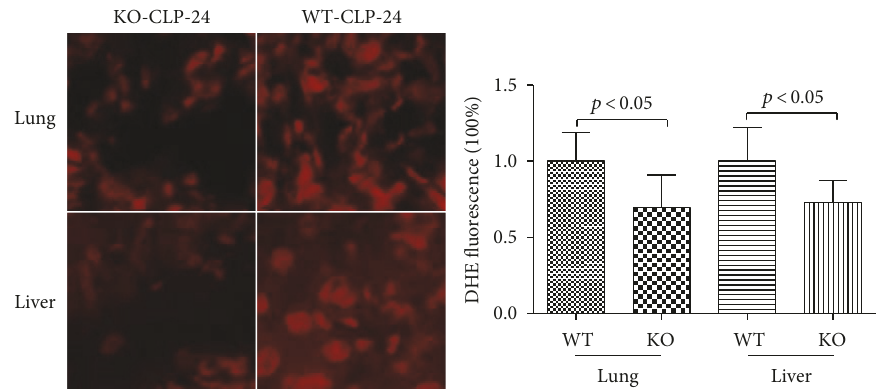
Figure 14: Lack of 5-HT decreases the level of ROS in CLP-induced sepsis. DHE fl uorescence intensity was used to detect ROS after CLP in the lung and liver. The KO-CLP sepsis group had a lower level of fl uorescence intensity than the WT-CLP sepsis group in both the liver and lung. All data are expressed as the mean ± SD. p < 0 05 versus the WT-CLP